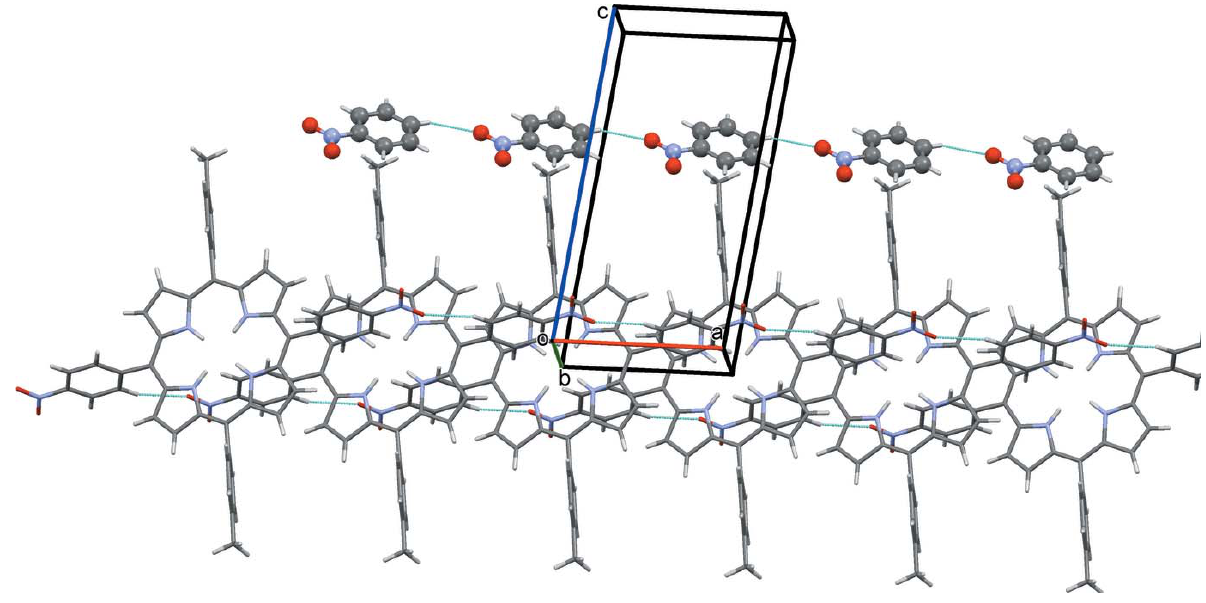
Figure 2 A partial view along the b axis of the crystal packing of the title compound. The C—H (cid:2)(cid:2)(cid:2) O hydrogen bonds are shown as dashed lines (see Table 1).